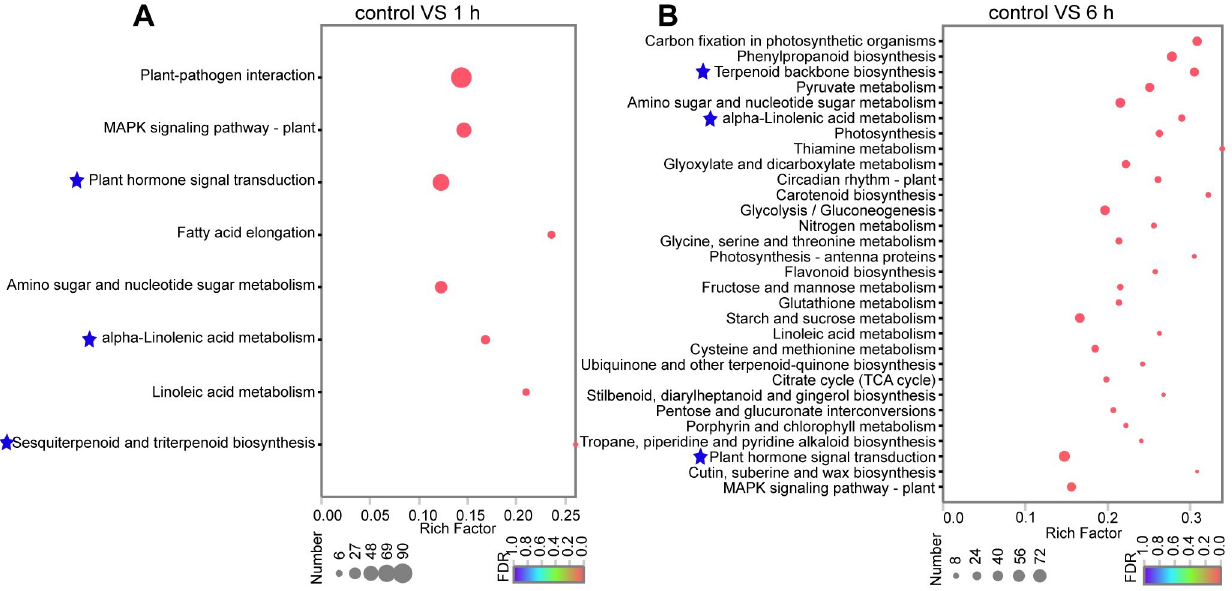
Fig 4. KEGG enrichment analysis of DEGs in C . wenyujin with MeJA-treatment for “control vs 1 h” (A) and “control vs 6 h” (B) groups. The y-axis on the right side represents the KEGG pathway and x-axis represents rich factor. The size of the dot indicates the number of genes in KEGG pathway, and the color of the dot corresponds to different FDR ( p -vaule). p -vaule < 0.05 indicates significant enrichment of KEGG pathway. Up to top 30 of significant enrichment results are displayed.